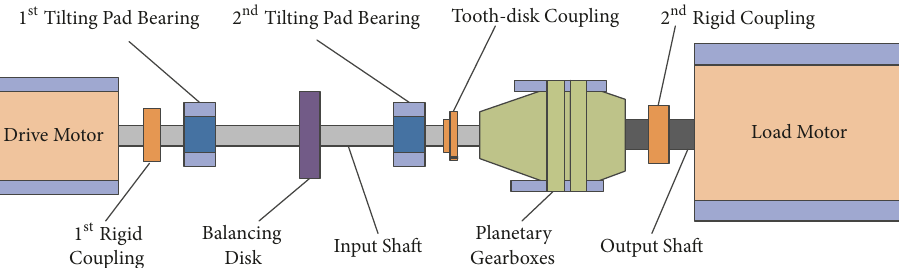
Figure 1: Schematic of the two-stage planetary gear rotor system.